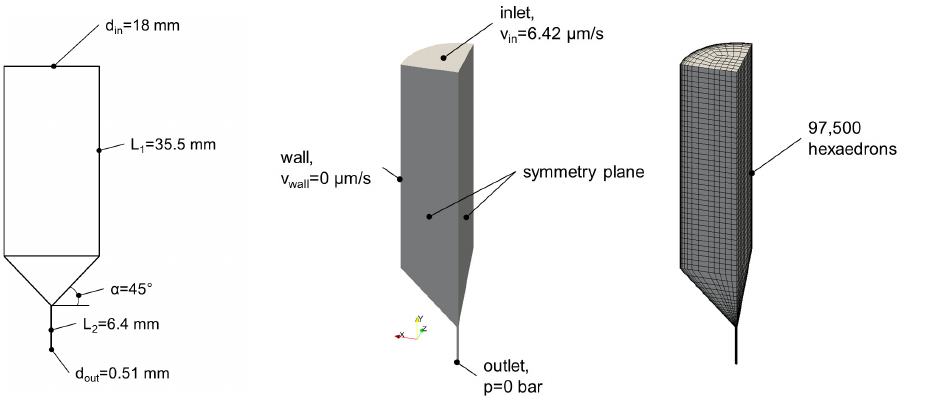
Figure 9. Left : Longitudinal section of the printer cartridge used. The cross-section of the dispensing capillary was circular. Middle : Parameters used for calculations. Right : Mesh used for